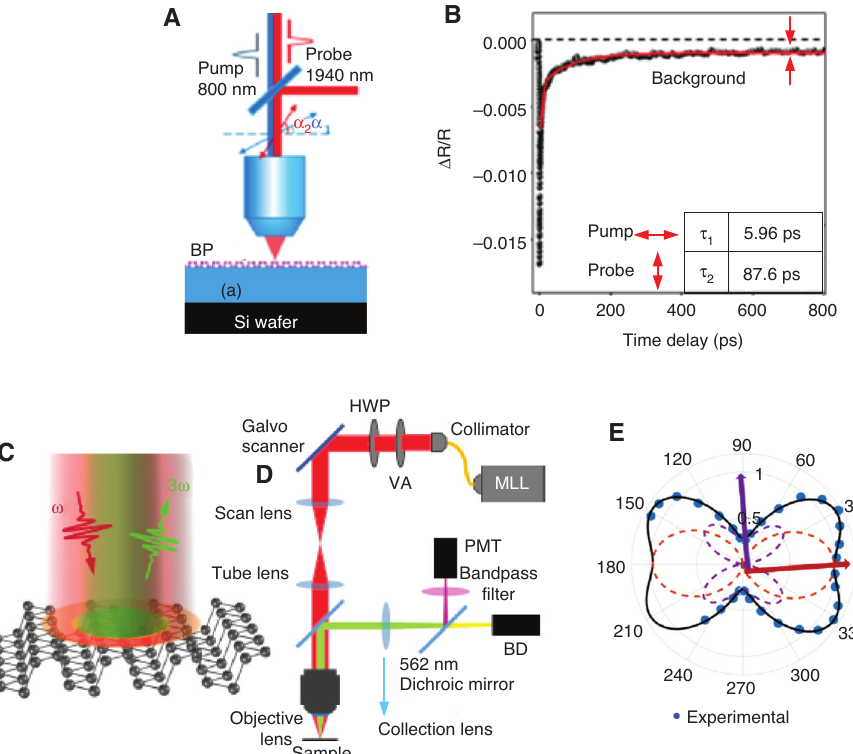
Figure 7: Polarization dependent linear reflection contrast and THG spectra of BP flake [143, 144]. (A) Polarization-resolved reflection experiment. (B) Measured relative change in reflection varying with pump-probe time delay Δ t (arrow: pump polarization along 0 ° and 90 ° ) [143]. The data is fitted with biexponential decay function (decay time constants: τ ps). (C) The THG of BP flake. (D) The experiment measurement equipment for THG. (E) Polar plot of the measured angular dependence of the THG from a 26-nm BP flake on a glass substrate. The red and purple arrows indicate the AC and ZZ crystal directions obtained from polarized Raman measurements